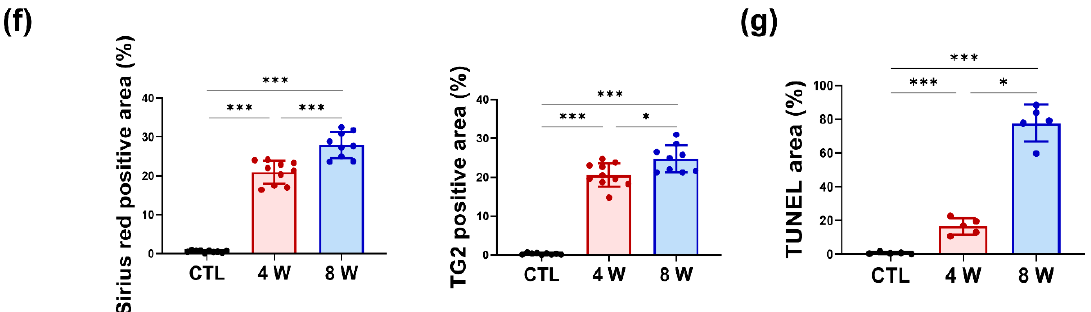
Figure 1. Increased TG2 levels were accompanied by pathological aggravation in UUO and 5/6 nephrected (Nx.) rodent models. UUO kidneys were evaluated thrice, on days 3, 7, and 14, after the establishment of the UUO model. ( a ) Representative images of UUO kidneys stained with Sirius red, immunohistochemical staining for TG2, and TUNEL assay on days 3, 7, and 14. ( b ) Semi-quantification results for Sirius red and TG2-stained UUO kidney. ( c ) Changes in TG2 mRNA abundance after 3, 7, and 14 days from UUO surgery. ( d ) Percentage of TUNEL positive area on days 3, 7, and 14. ( e ) In the 5/6 Nx. model, kidney tissue-expressed TG2 levels were evaluated twice at 4 and 8 weeks. Representative images of 5/6 Nx. kidneys stained with Sirius red, immunostained with TG2, and TUNEL assay. ( f ) Semi-quantification results for TG2-stained 5/6 Nx. Kidney. ( g ) Apoptosis was assessed twice at 4 and 8 weeks using the TUNEL assay. (Scale bar = 100 μ m, * p <0.05, ** p < 0.01, *** p < 0.001).